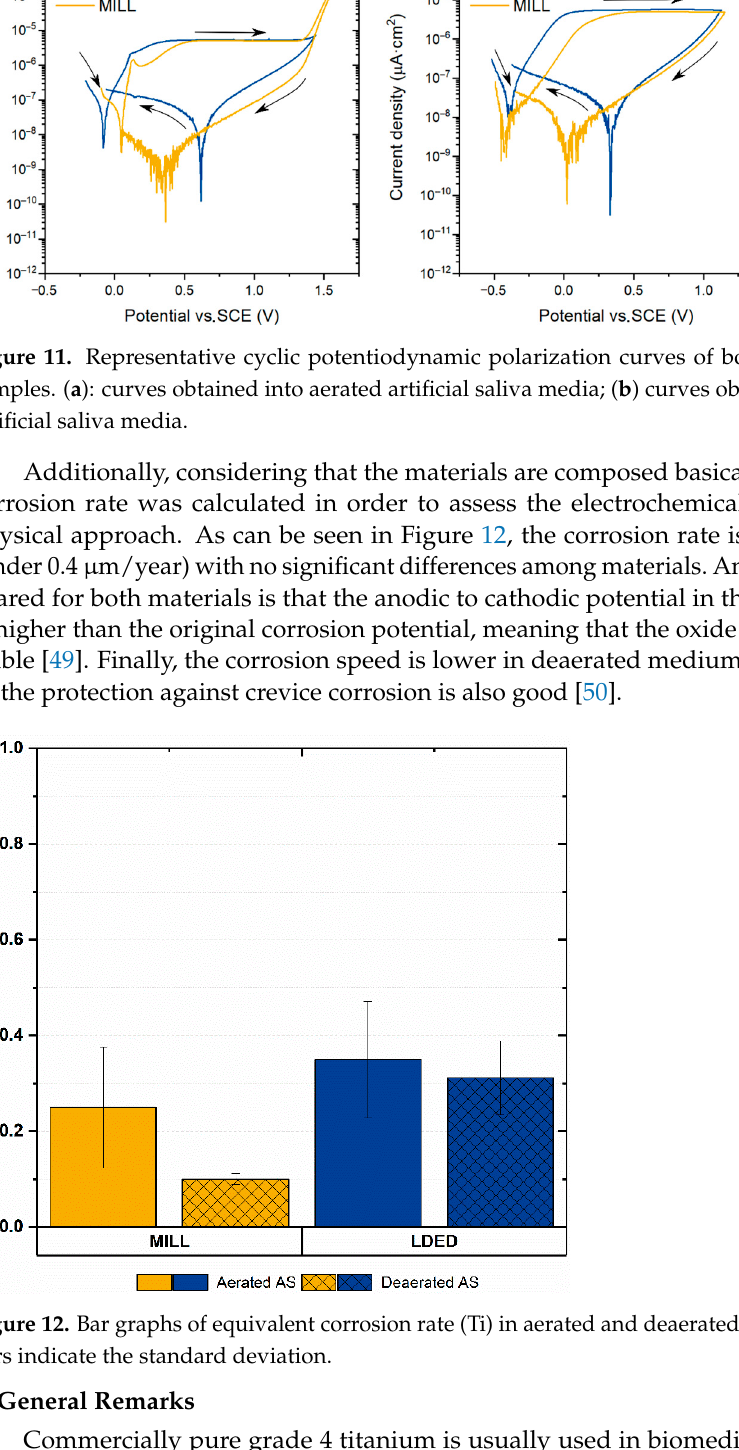
11 of 15 Figure 10. Fractography images of breaking surface. ( a1,b1 ): optical microscopy; ( a2,a3,b2,b3 ): BSE SEM microscopy. 3.3. Electrochemical Properties Cyclic potentiodynamic polarization (CPDP) analysis was performed to assess the electrochemical properties of both MILL and LDED alloys. These tests were performed in the anodic direction until the electrolysis water potential (around 1.3 V) because at this point the peak of current cannot be attributed to the breakdown potential (E b ) but to the decomposition of water. Then, the potential direction was reversed until corrosion poten- tial (E corr ). The media employed was aerated AS, in order to assess the corrosion behavior of the buccal environment, as well as deaerated AS to assess the crevice corrosion in zones where the fluid has limited access, such as the gap between implant and abutment. CPDP curves (Figure 11) of both materials present a similar behavior with a very low current density at corrosion potential (E corr ). No presence of pitting corrosion was found in both aerated and deaerated media, verified with the negative hysteresis in the reverse